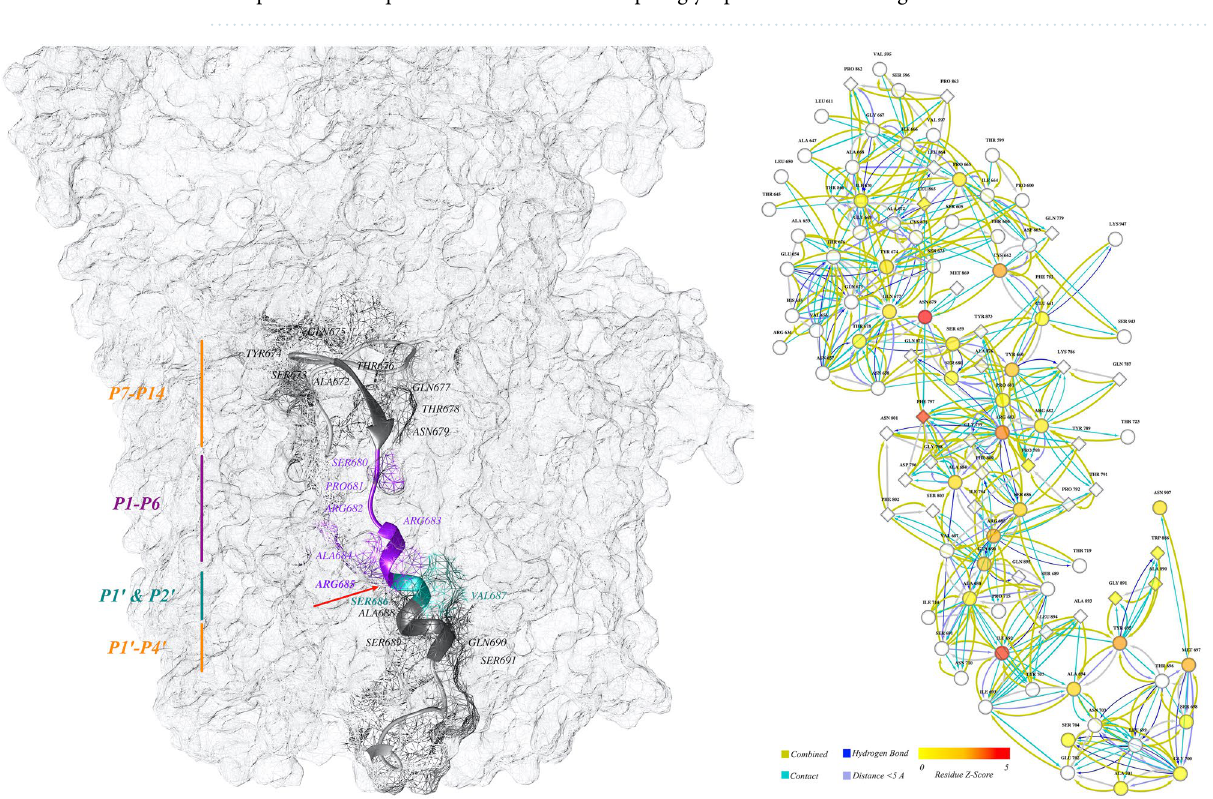
Figure 8. Cartoon presentation of the stalk of the SARS-CoV-2 spike glycoprotein. The left panel shows the stalk of the SARS-CoV-2 spike glycoprotein. The furin cleavage motif is discriminated against by colored ribbons; other ribbons were hidden for better presentation. The positions of the different boxes of the furin cleavage motif are illustrated by vertical lines; the color scheme is based on reference 38 . The different parts of the furin binding site are assigned by different colors of ribbons, and the red arrow shows the exact cleavage site between residues of Arg685 and Ser686. The right panel shows the network interaction of the furin binding site and other residues in the trimeric structure. The ellipses are residues of the binding site and diamonds are the residues on the nearby chain. The filled color is based on Z-score, and edges are different interactions (color key at the bottom). The cartoon representation of the protein is generated by Chimera (ver. 1.13); the network in the left panel is made by Cytoscape (ver.